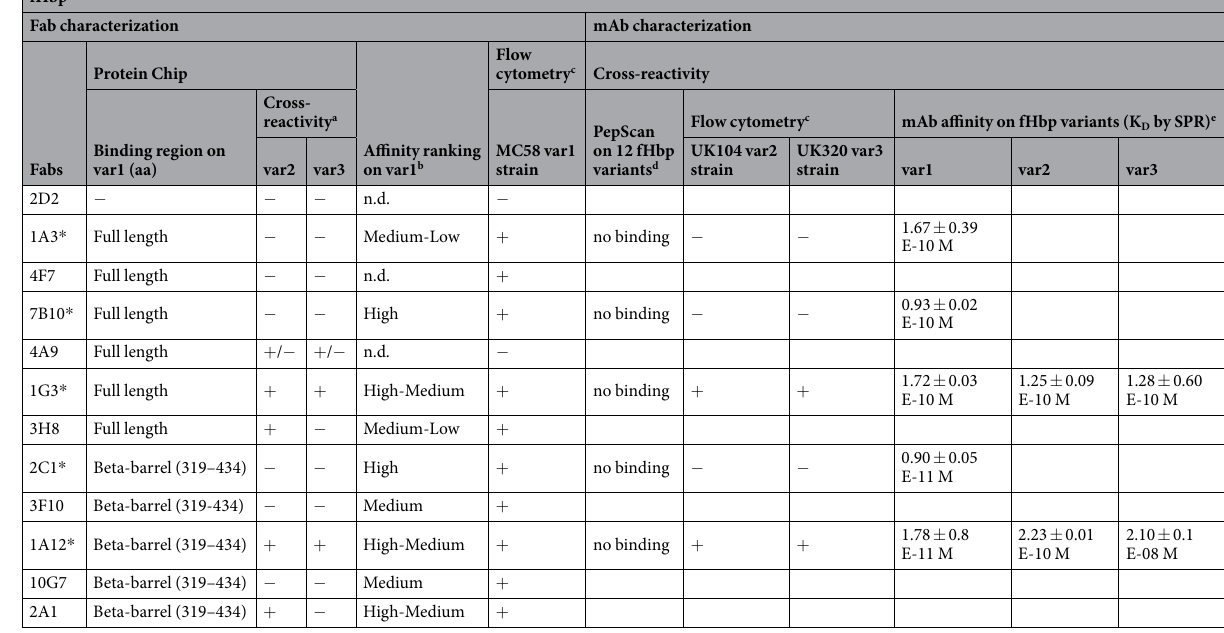
Table 2. Main features of selected anti-fHbp Fabs and mAbs. * Fabs selected for full-length IgG1 production. a Fabs cross-reactivity evaluated by Protein chip is indicated as “ + ” or “ − ” if a positive signal or no signal was detected and as “ + / − ” when a low intensity signal was observed. “var” indicates protein variant. b Affinity ranking was defined by GyroLab based on W score: Fabs with W scores lower than 6 were ranked as “High” affinity Fabs (K D > 10E-10M), Fabs with 6 < W < 9 were ranked as “Medium” affinity (10E-10M < K D < 10E- 8M); Fabs with W score > 9 were ranked as “Low” affinity (K D > 10E-8M); “n.d.” stands for not detected. c Ability of Fabs and mAbs to bind to antigen expressed on bacterial surface is indicated as “ + ” or “ − ” if a positive shift or no signal was observed by Flow cytometry analysis respectively. d For mAbs characterization, linear epitopes identified by PepScan and cross-reactivity on 12 fHbp variants (1.1/1.4/1.13/1.14/1.15/2.16/2.19/2.25/2.77/3.2 8/3.45/NL10A) are reported when available while “no binding” indicates that no signal was detected in tested conditions; e mAbs affinity to 4CMenB variant as well as to other variants for cross-reactive mAbs is reported as K D derived from Surface Plasmon Resonance